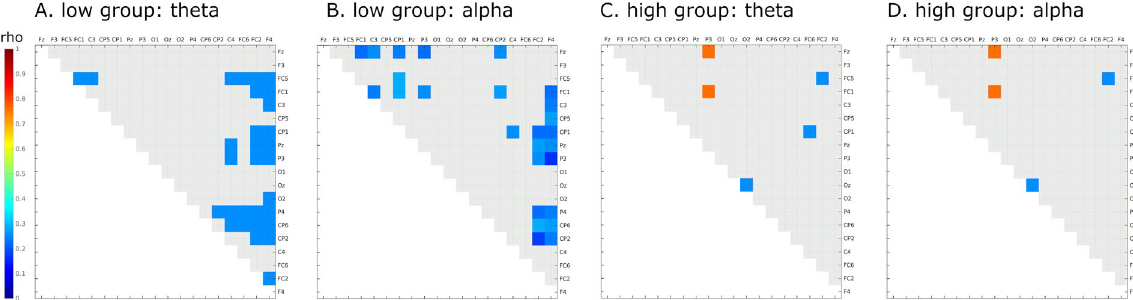
Figure 6. Significant (p < 0.05, uncorrected) differences in the PLVs between retest and test sessions for the low gB2rest (n = 8, A, B) and high gB2rest (n = 14, C, D) groups in the shooting task. Red and blue colors depict significant positive and negative differences, respectively, between retest and test. Light gray squares denote lack of significance. Analyses were conducted for bands that showed significant correlations between gB2rest and PLV (comp. Figure 5).